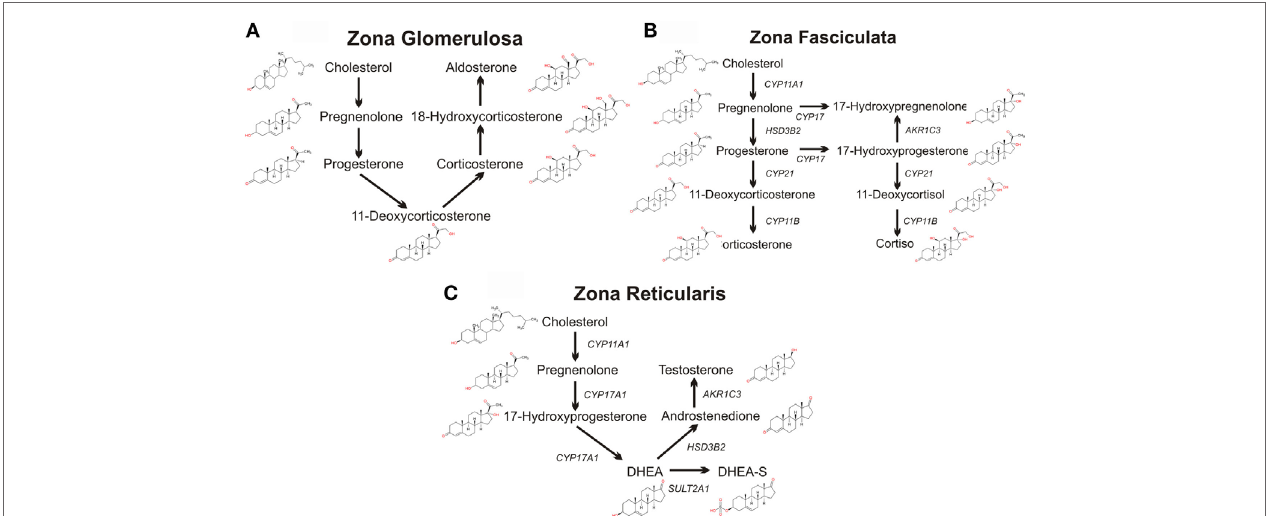
FiGURe 2 | Schematics of adrenal steroidogenic pathways . The metabolism of cholesterol to pregnenolone by the mitochondrial CYP11A1 is common to all three zones of the human adrenal. (A) The mitochondrial/microsomal enzyme HSD3B converts pregnenolone to progesterone, which is metabolized to 11-deoxycorticosterone by the microsomal CYP21. The final reactions of aldosterone synthesis are catalyzed by the mitochondrial CYP11B2, which converts 11-deoxycorticosterone to corticosterone, which is hydroxylated at C18 to form 18-hydroxycorticosterone which is then finally converted to aldosterone. (B) In the zona fasciculata, the microsomal CYP17 and the mitochondrial/microsomal HSD3B can generate 17-hydroxyprogesterone, progesterone, and 17-hydroxyprogesterone. The microsomal CYP21 preferentially metabolizes 17-hydroxyprogesterone to 11-deoxycortisol, which is finally metabolized to the glucocorticoid cortisol by the microsomal CYP11B2. CYP21 can also metabolize progesterone to 11-deoxycorticosterone, which CYP11B2 converts to the glucocorticoid corticosterone, although this pathway is secondary in humans (although the principal pathway in rodents). (C) In the zona reticularis, CYP17 hydroxylates pregnenolone to 17-hydroxypregnenolone, and then DHEA. DHEA is the major steroid product of the reticularis, with sulfated DHEA (DHEA-S), androstenedione, and testosterone serving as only minor steroidogenic